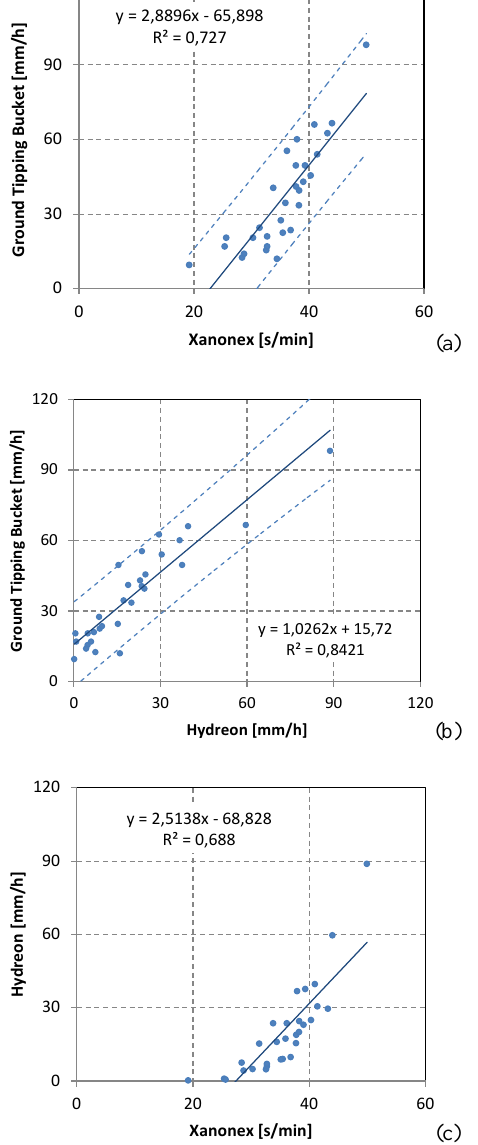
Fig. 7. Comparison of the optical sensors with the reference device, tipping bucket, with 95% prediction